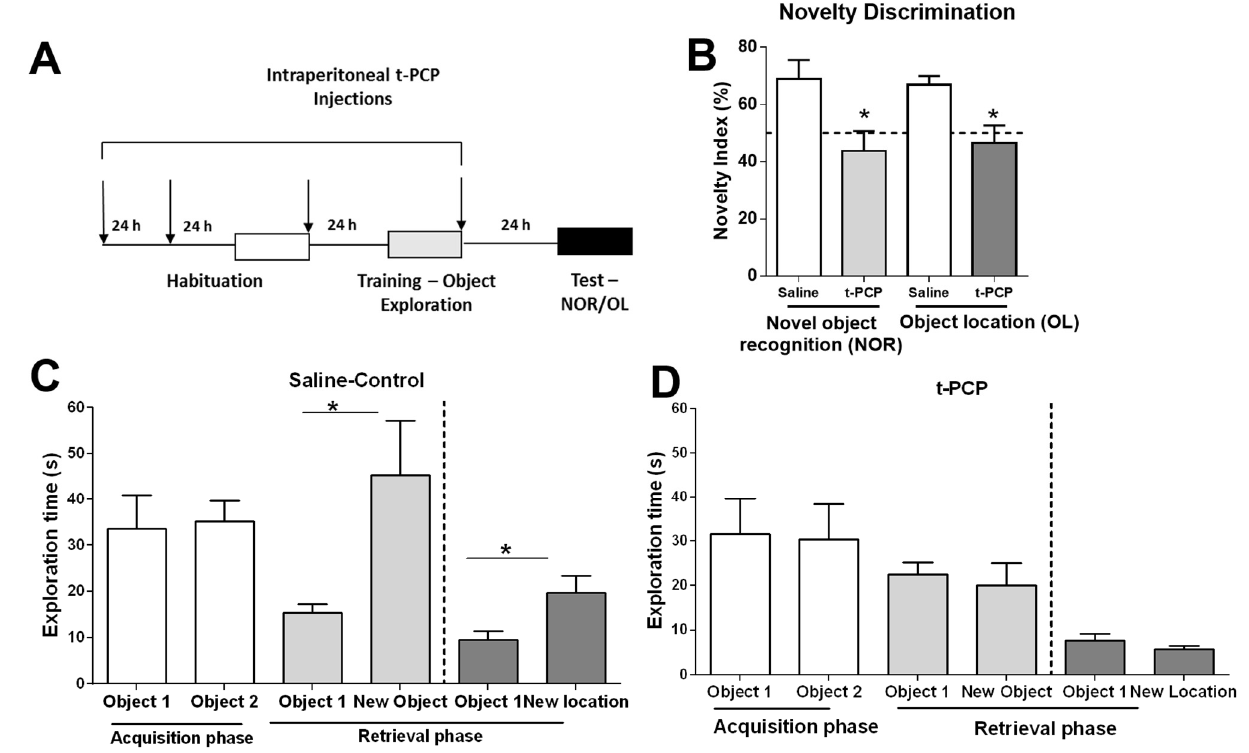
Figure 5 . LSD1 inhibition impairs memory formation in young adults. ( A ) Diagram of the experimental design for the novel object recognition (NOR) and object location (OL) learning paradigms. Animals were IP injected with t-PCP or saline-vehicle as indicated; ( B – D ) LSD1 inhibition impaired performance in NOR and OL learning tasks; ( B ) Discrimination index [calculated as NS/(FS+NS)*100; FS = familiar stimulus; NS = novel stimulus], with an index ≥ 50% indicating levels of memory retention. Novelty exploration data for saline-vehicle controls ( C ) and t-PCP-treated animals ( D ) are presented as the total duration, in seconds, of exploration per object. During the training or acquisition phase, objects 1 and 2 represented two identical sample objects. During the testing or retrieval phase, object 1 represented the familiar object or location, and the new object or location are represented as such. Group sizes NOR: Saline, n = 6; tPCP, n = 4; OL: Saline, n = 5; tPCP, n = 5. Student’s t-test ; ns = not significant, * p < 0.05, Error bars represent the